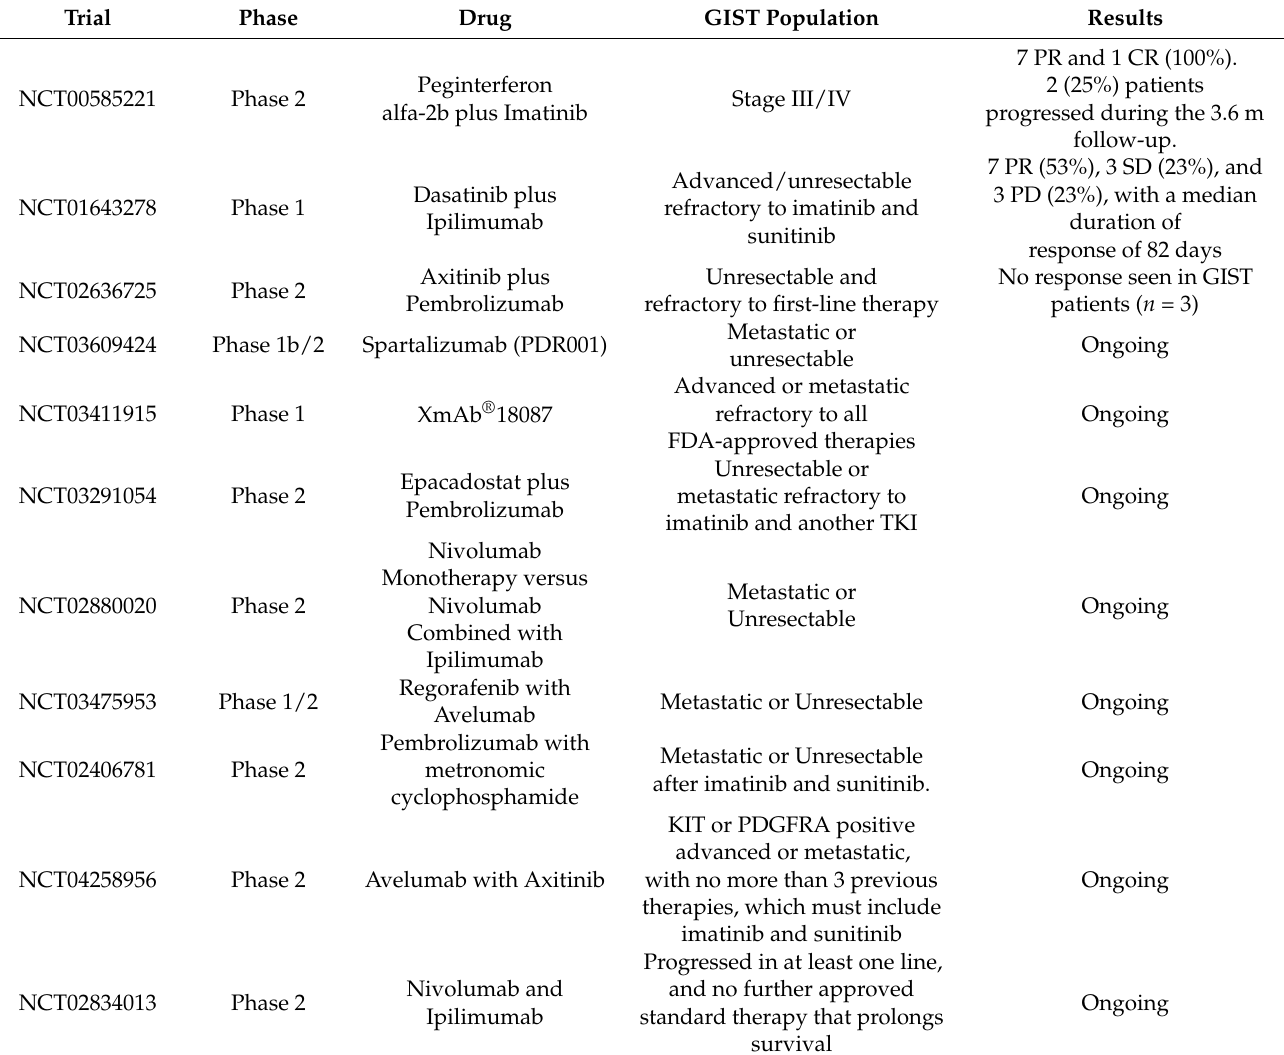
Table 1. Clinical trials on immunotherapy in